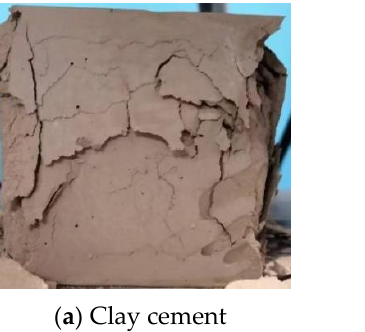
Figure 9. The slurry hardened body is damaged under pressure.